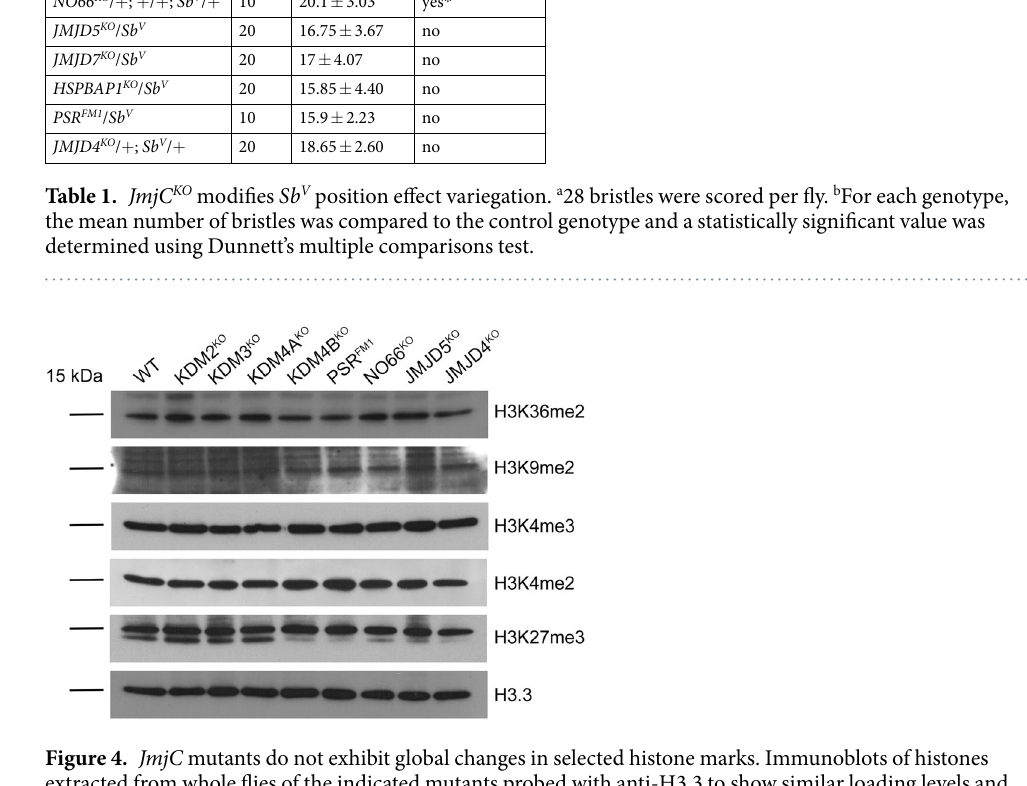
We next tested whether loss of JmjC genes affected global levels of methyl marks using Western blot analy- sis. We assayed eight mutant lines ( KDM2 , KDM3 , KDM4A , KDM4B , PSR , NO66 , JMJD5 , JMJD4 ), which are homozygous viable and predicted to affect specific methyl marks according to published reports on their mam- malian counterparts (Fig. 1) and/or our PEV assays (Fig. 3). We analyzed equal amounts of extracted histones from whole flies using the following antibodies: H3K27me3, H3K4me2, H3K4me3, H3K9me2, H3K36me2 (Fig. 4). Our western blot analyses do not reveal any obvious global changes in the marks tested. These data are not surprising considering a recent report, which also failed to detect global changes in H3K27me3 levels in UTX mutant cells in larval imaginal discs using immunohistochemistry 19 . JmjC genes modulate different signaling pathways. Our finding that at least eight JmjC mutants affect chromatin organization without obviously impairing development raises questions about the roles of such chro- matin regulation. Do these mutants affect gene regulation, and if yes, under which conditions? Drosophila allows for the quantitative assessment of relevant modulatory effects in both genetically sensitized backgrounds as well as controlled isogenic wild-type backgrounds. To first test which JmjC genes modulate different pathways that specify cell fate and growth, we placed the JmjC KO alleles into three sensitized genetic backgrounds. Based on previous observations that specific JmjC proteins influence ribosome biogenesis 42–44 and that at least one Drosophila JmjC protein, NO66, localizes to the nucleolus (Fig. 2 and Supplemental Fig. 2), we assayed